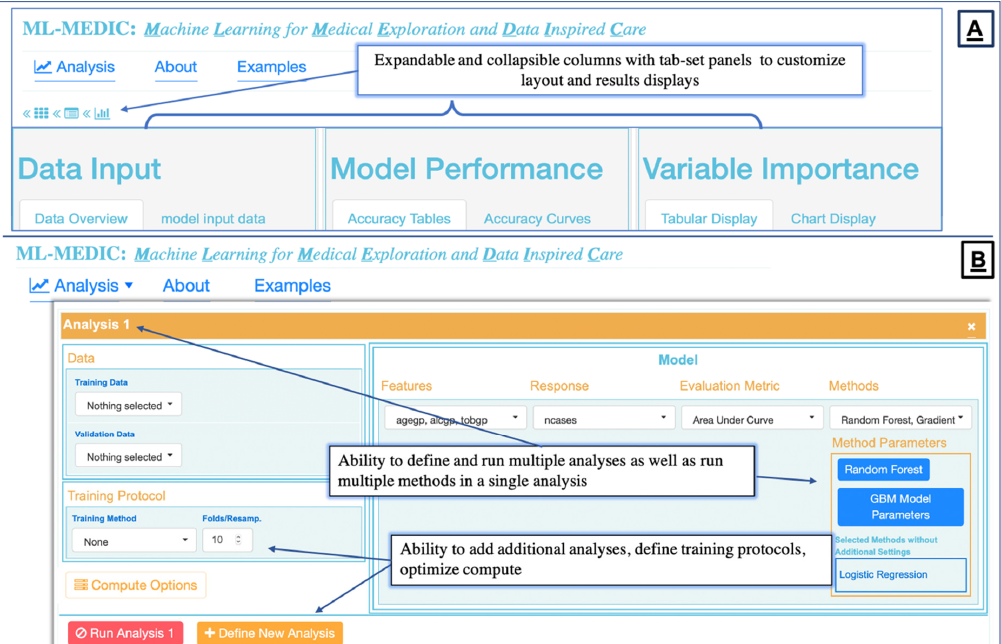
Figure 2. ( A ) Overall layout of ML ‐ MEDIC. Expandable and Collapsible panels combined with tabular and graphical displays of results allows users to customize outputs and necessary visualizations at any point in the ML workflow. ( B ) Analysis dropdown menu allows for users to define one or multiple analyses and customize data input, training protocols, evaluation metrics, and run multiple ML and statistics models at once.